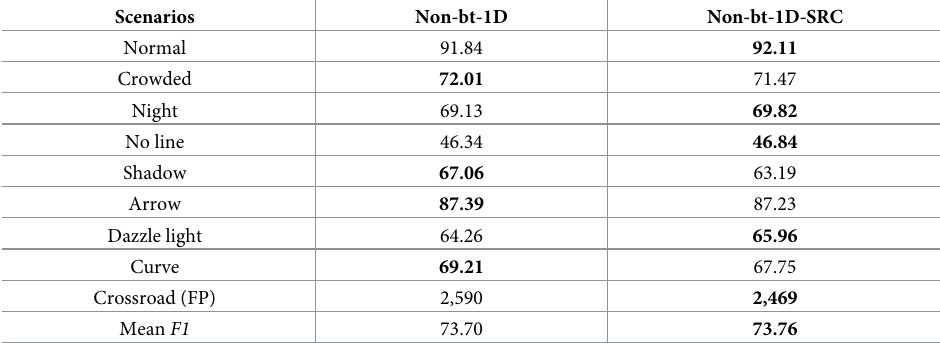
Table 2. Comparison between the results obtained using the Non-bt-1D and Non-bt-1D-SRC encoders.